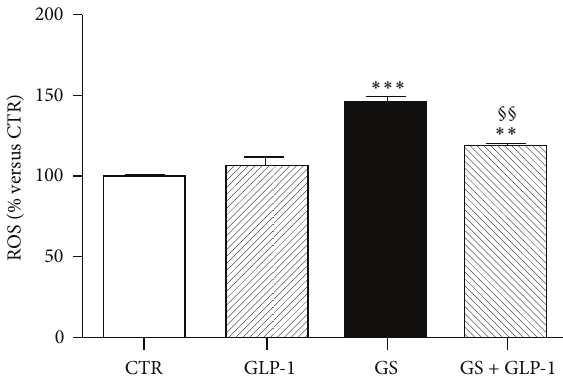
Figure 1: GLP-1 abrogates AGE-induced intracellular ROS pro- duction. After treatment for 5 days in standard medium (CTR) or in medium containing AGEs (GS) in the presence or absence of 10nmol/L GLP-1, HIT-T15 cells were prelabeled with DCFH-DA for 30min and fluorescence was analyzed. Data were expressed as the mean ± SE of four independent experiments. ∗∗ 𝑃 < 0.01 and ∗∗∗ 𝑃 < 0.001 versus CTR; §§ 𝑃 < 0.01 versus GS.